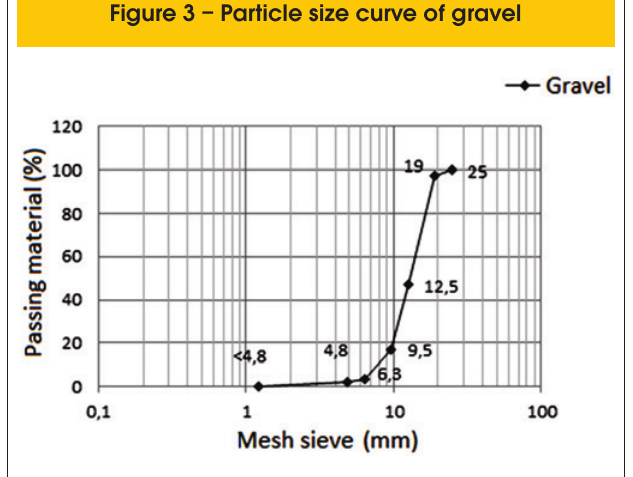
Figure 3 – Particle size curve of gravel